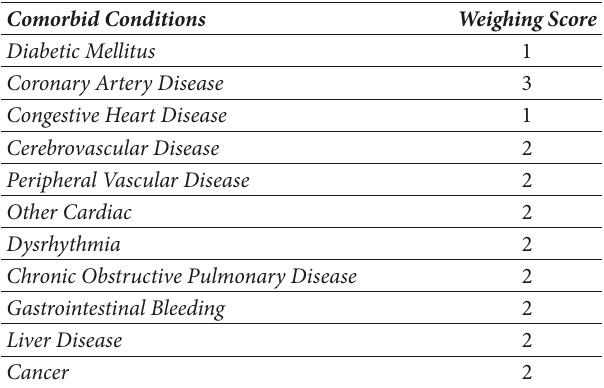
Table 1: Liu Comorbidity Index, 11 comorbid conditions, and weighing score.